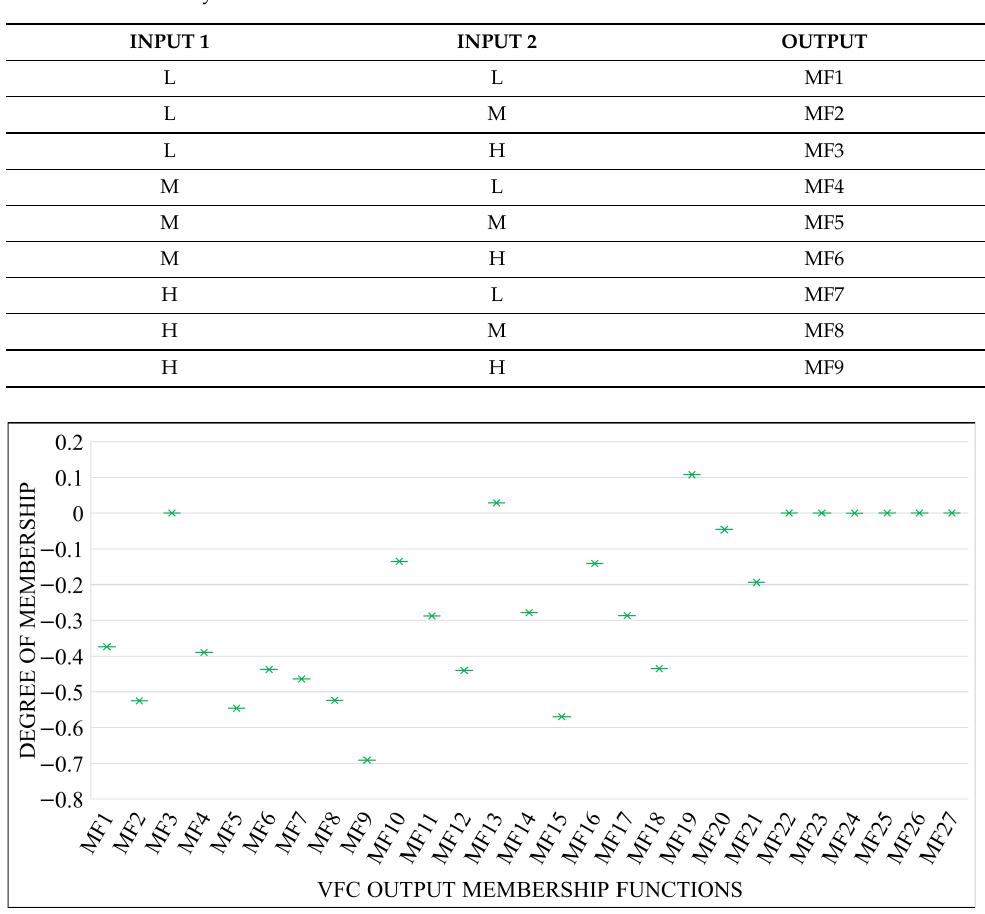
Figure 11. Output defuzzification membership functions of the VFC controller.